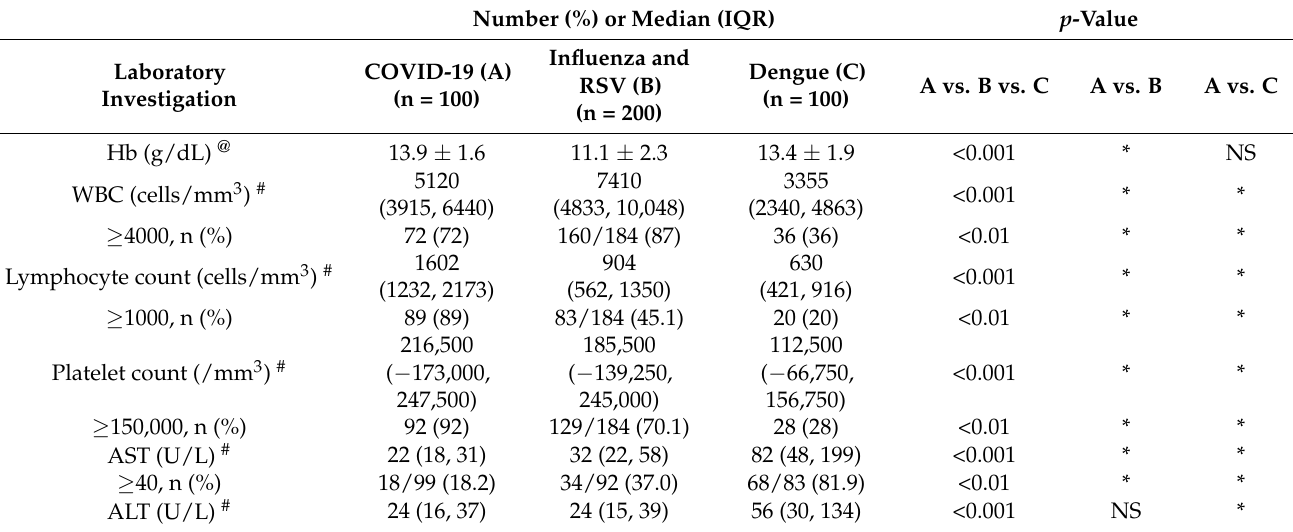
Table 4. Comparison of initial laboratory investigations.